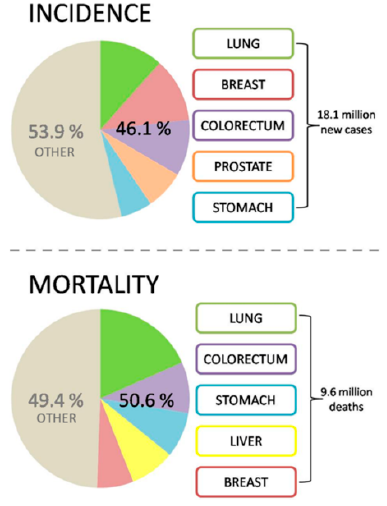
Figure 1. Global cancer statistics demonstrating the most prevalent cancer types; the image is based on the data published by 2019 [1].